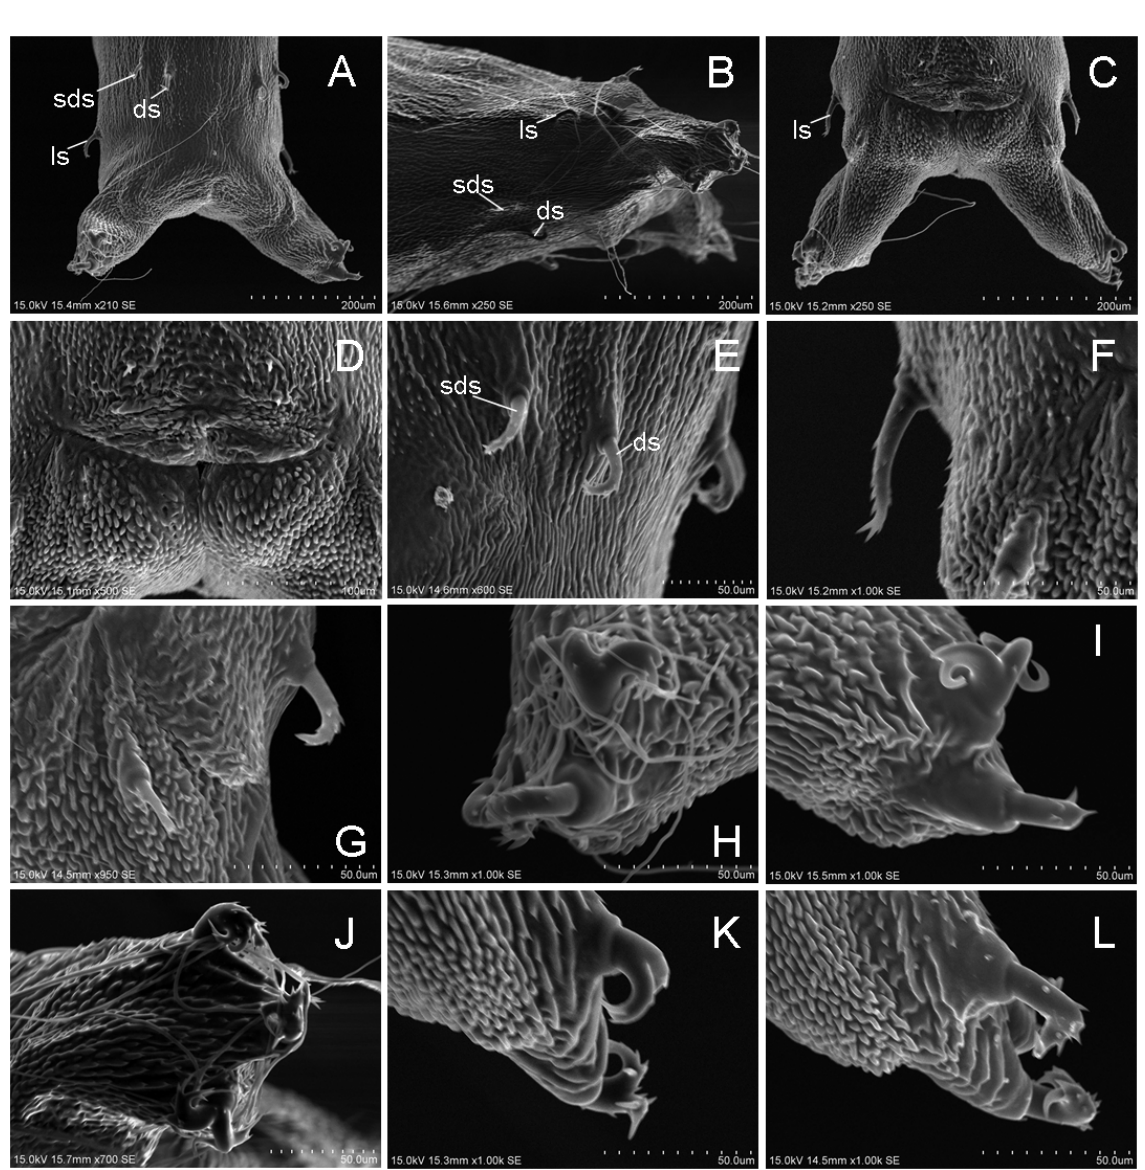
Fig. 12. SEMs of pupal abdominal segments A9–A10 of Tonza citrorrhoa Meyrick, 1905 (OPU-IN- LE2018IV0018 -0020). A . Ventral view. B . Lateral view. C . Dorsal view. D . Middle portion of A10. E . Ventral setae of A9. F . Lateral seta of A10. G . Dorsal setae of A10. H . Apical setae of right process of cremaster, ventral view. I . Same, left process. J . Left process of cremaster, lateral view. K – L . Apical setae of right process of cremaster, dorsal view. Abbreviations: ds = dorsal seta; ls = lateral seta; sds = subdorsal seta; svs = subventral seta; vs = ventral